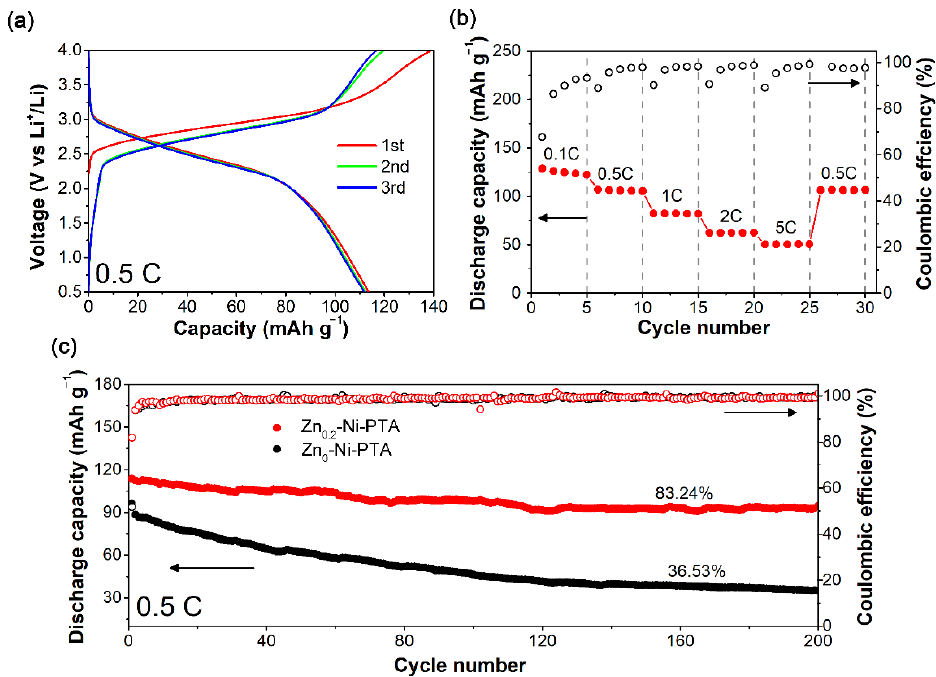
Figure 5. ( a ) Charge – discharge curves, ( b ) rate performance and ( c ) cycle performance of Zn 0.2 -Ni- PTA/LiFePO 4 full cell.